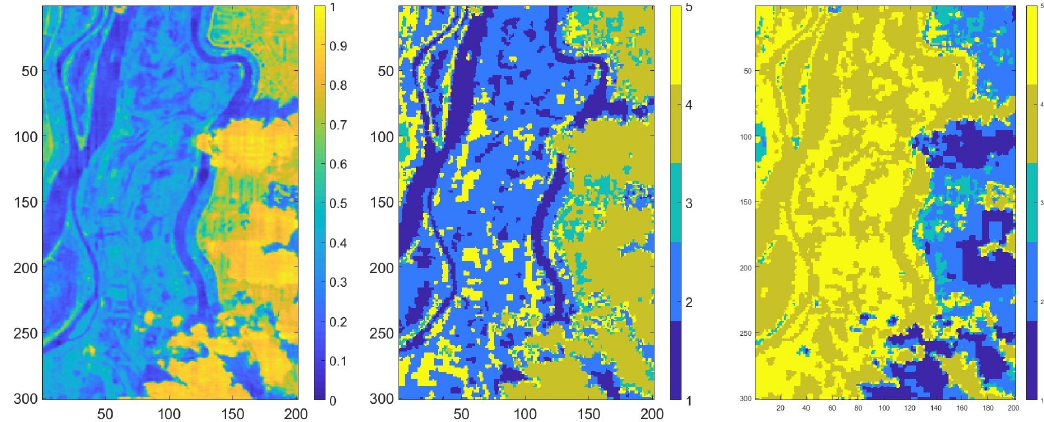
Figure 8. The abundances map of the Br˘aila dataset ( left ), the classified images using seven unsupervised classifiers ( center ) and nine unsupervised classifiers ( right ).